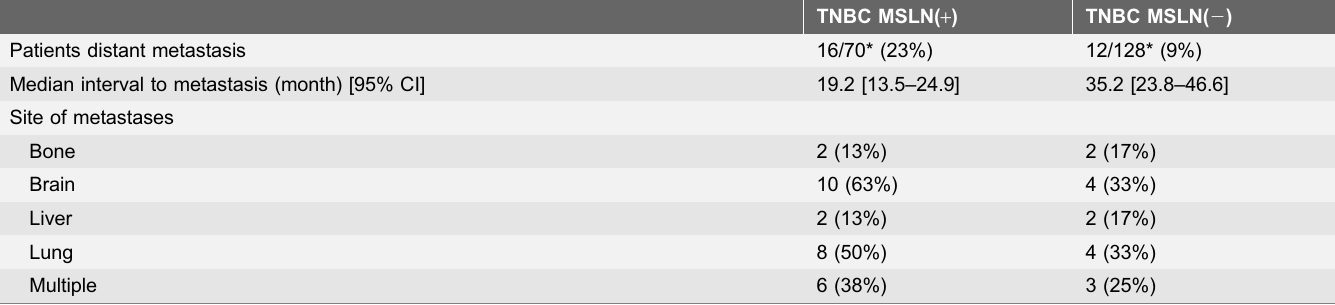
Table 6. Correlation of MSLN expression and Distant Metastasis.